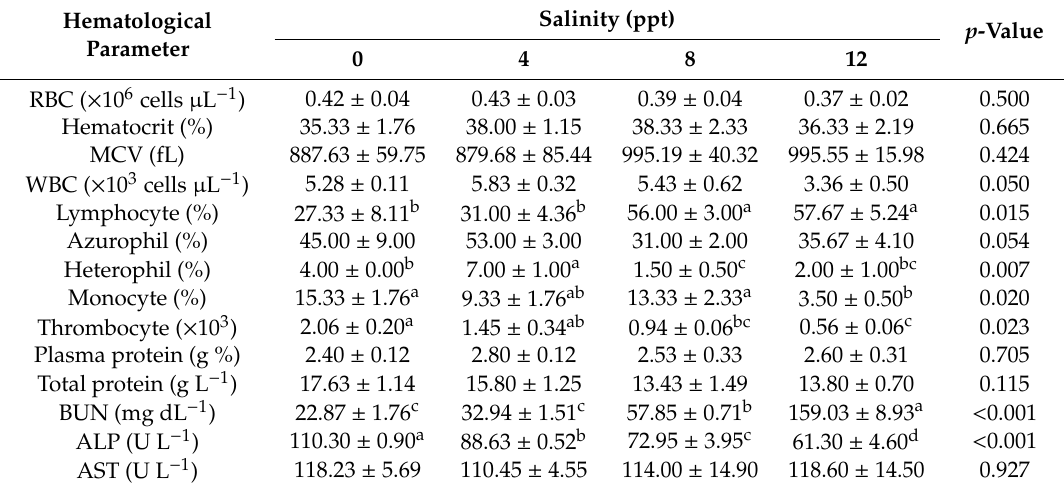
Table 4. Hematological parameters of northern river terrapin reared in various salinities. The sampling was done at the end of the 8-week